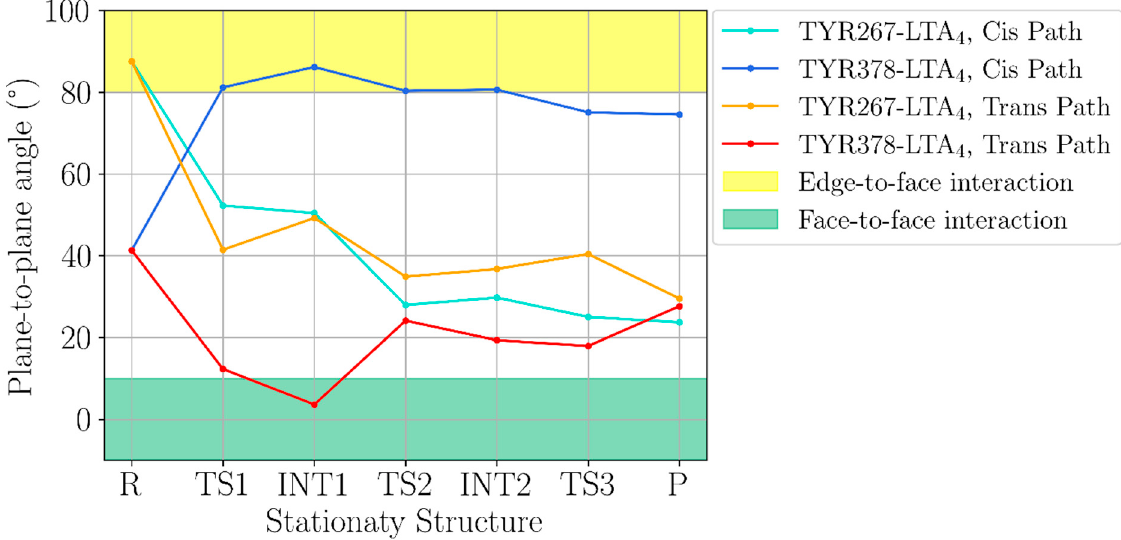
Figure 15. Angles between the plane of the triene moiety of the substrate and the planes of the aro- matic rings of TYR267 and TYR378 for the different stationary structures located along the pro- cis and the pro- trans reaction paths. The closest plane to the whole number of C and H atoms of the triene system was taken as the plane of this triene moiety.